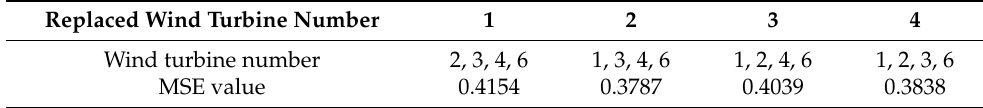
Table 1. MSE values of wind turbine NO. 6 instead of wind turbine Nos. 1–4.